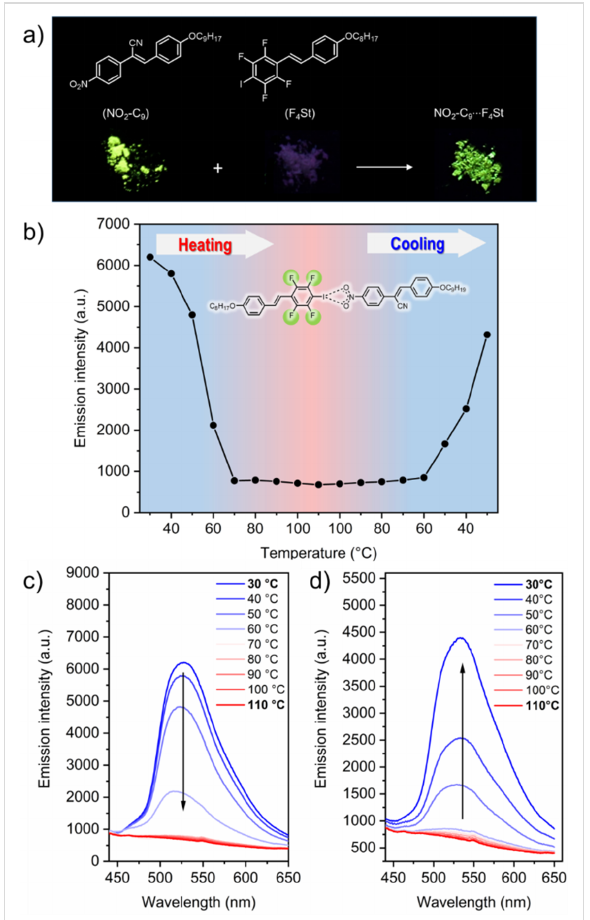
Figure 7: Fluorescence studies of NO 2 -C 9 ∙∙∙ F 4 St . The photographs of the solid components as well as the formed complex under UV light ir- radiation ( λ ex = 365 nm) reveal the change in fluorescent intensity upon complexation (a); fluorescence intensity plot as a function of the temperature upon heating from room temperature to 110 °C and subsequent cooling back to room temperature (b); emission spectra showing a gradual decrease in emission intensity upon heating (c) and cooling